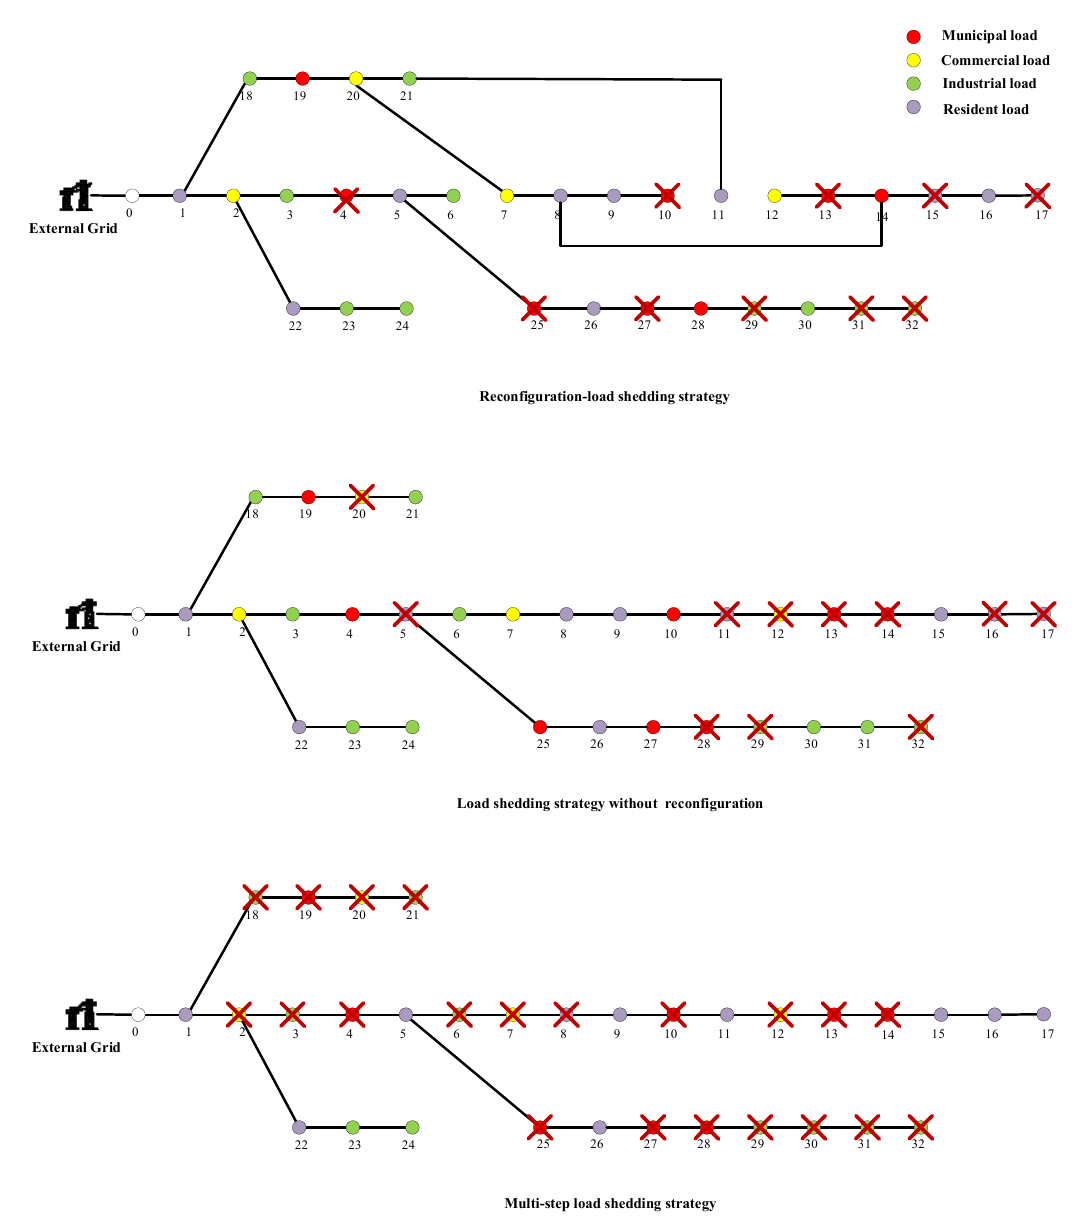
Figure 10. Removed loads distribution with the lowest shed power as the main objective.